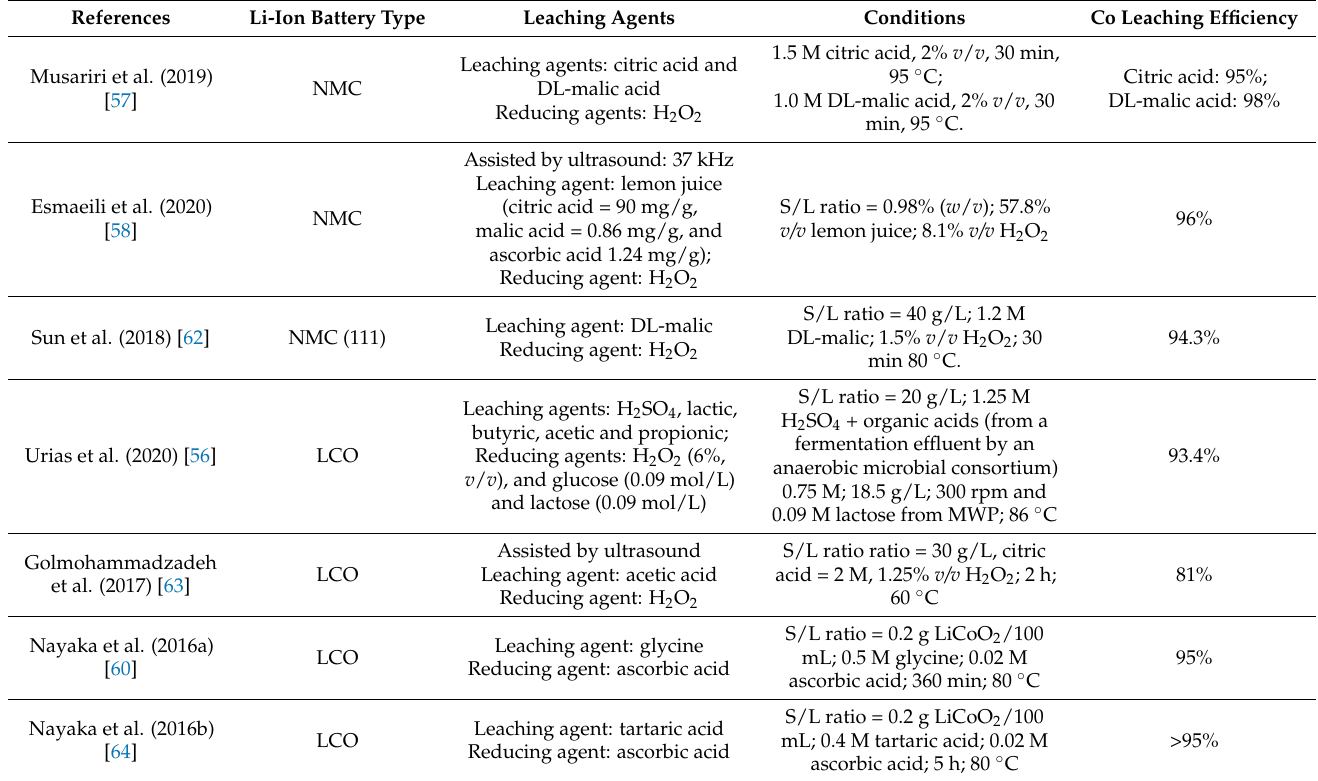
Table 3. A literature review of Li-ion battery leaching by inorganic